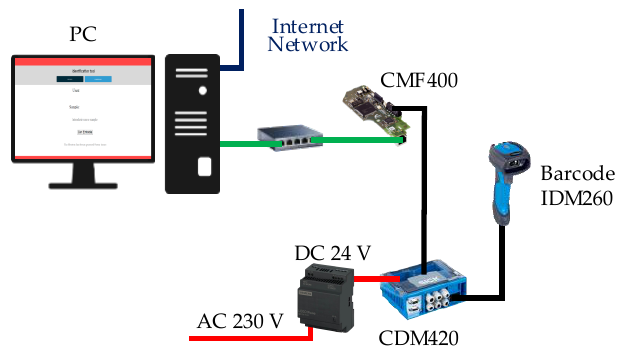
Figure 10. PC Platform connections with ethernet barcode connectivity.